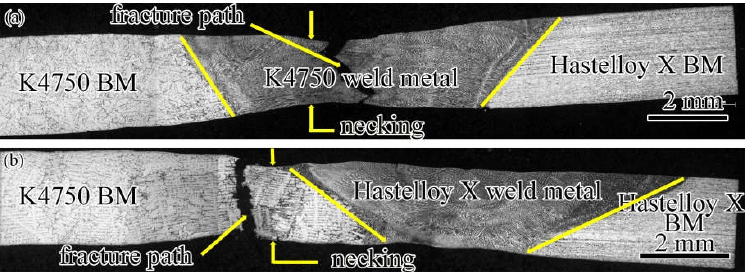
Figure 12. Tensile fractured samples of the dissimilar joints with different filler materials ( a ) K4750 filler material; and ( b ) Hastelloy X filler material.